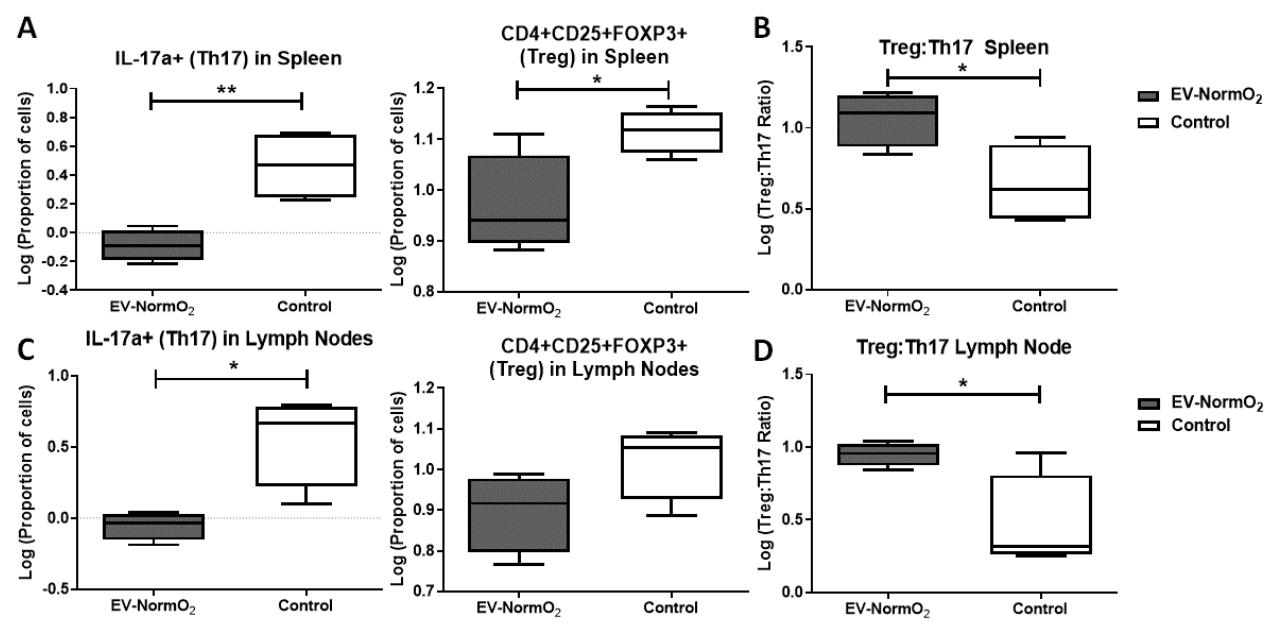
Figure 4. Outcomes of intracellular staining for T cell polarisation analysis. ( A – D ) Intracellular staining for FACS analysis of IFN- γ , IL-4 and IL-17a in CD4+ T cells from EV-NormO 2 versus PBS control. Significant reductions in ( A , C ) IL-17a expression suggestive of reduced Th17 polarisation in Spleen and Lymph Node with a small or insignificant change in regulatory T cell polarisation ( B , D ) resulted in trend for restoration of the Treg:Th17 balance in EV-NormO 2 treated mice which were found significant in lymph node cells only ( n = 4, * p < 0.05; ** p < 0.01) (Unpaired T Test using log-transformed